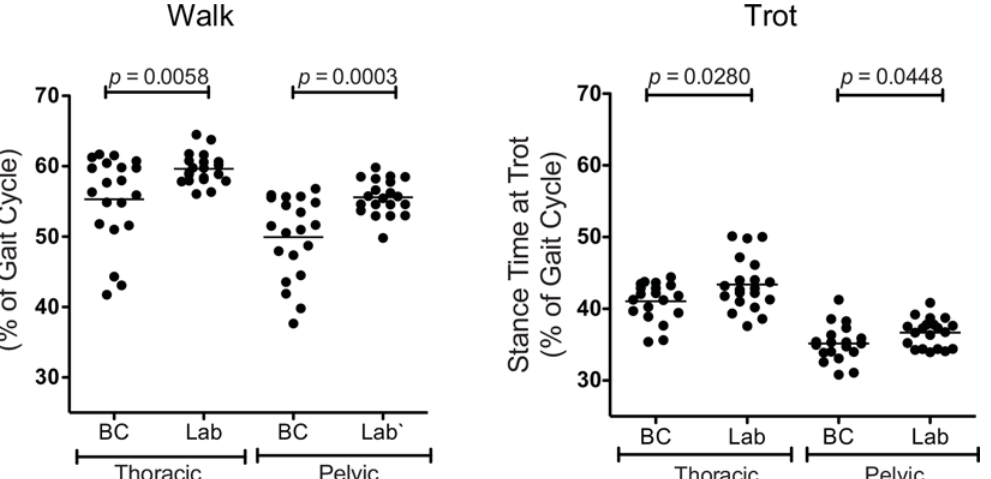
Fig 4. Stance Time as a Percentage of Gait Cycle (ST%) of the Thoracic and Pelvic Limbs at the Walk and Trot in Border Collies and Labrador Retrievers. Left. The Border Collies spent a significantly shorter proportion of the walking gait cycle with their thoracic and pelvic limbs in contact with the ground than the Labrador Retrievers ( p < 0.0058 and p = 0.0003, respectively. Right. The Border Collies also spent a significantly shorter proportion of the trotting gait cycle with their thoracic and pelvic limbs in contact with the ground than the Labrador Retrievers ( p < 0.0280 and p = 0.0448,